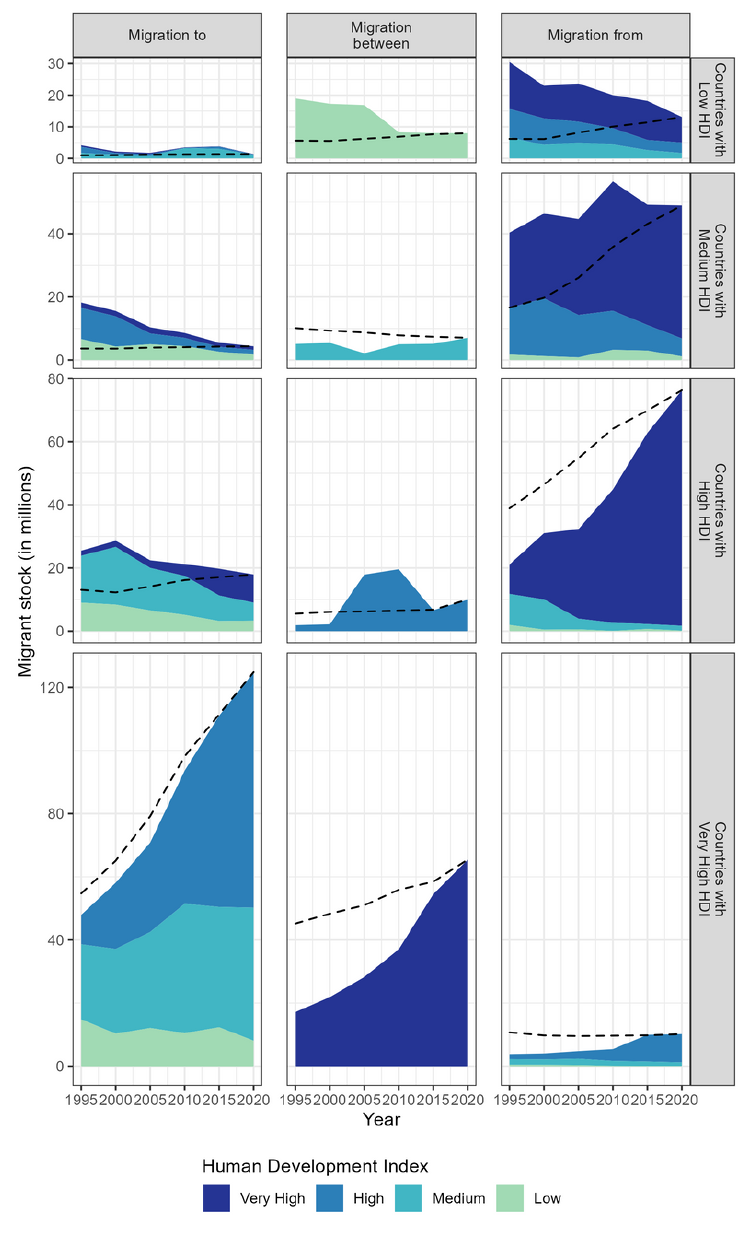
Figure 3. Migrants to, between, and from each of the four HDI categories (low, medium, high, and very high), 1995–2020. From UN DESA (2021b) and UNDP (2020). ‘Migration to’ plots refer to migration to that HDI category from the other HDI category countries; ‘Migration from’ plots refer to migration from that HDI category to the other HDI categories. The data points at the 5-year intervals in the color bands reflect the HDI categorization at that time; the black dotted line uses 2020 HDI classifications across all data points (i.e., 1995 through The reclassification of countries helps partly explain the different patterns of migrants found in previous studies to those in Figure 2. In order to explore the underlying migration dynamics and their relationship with